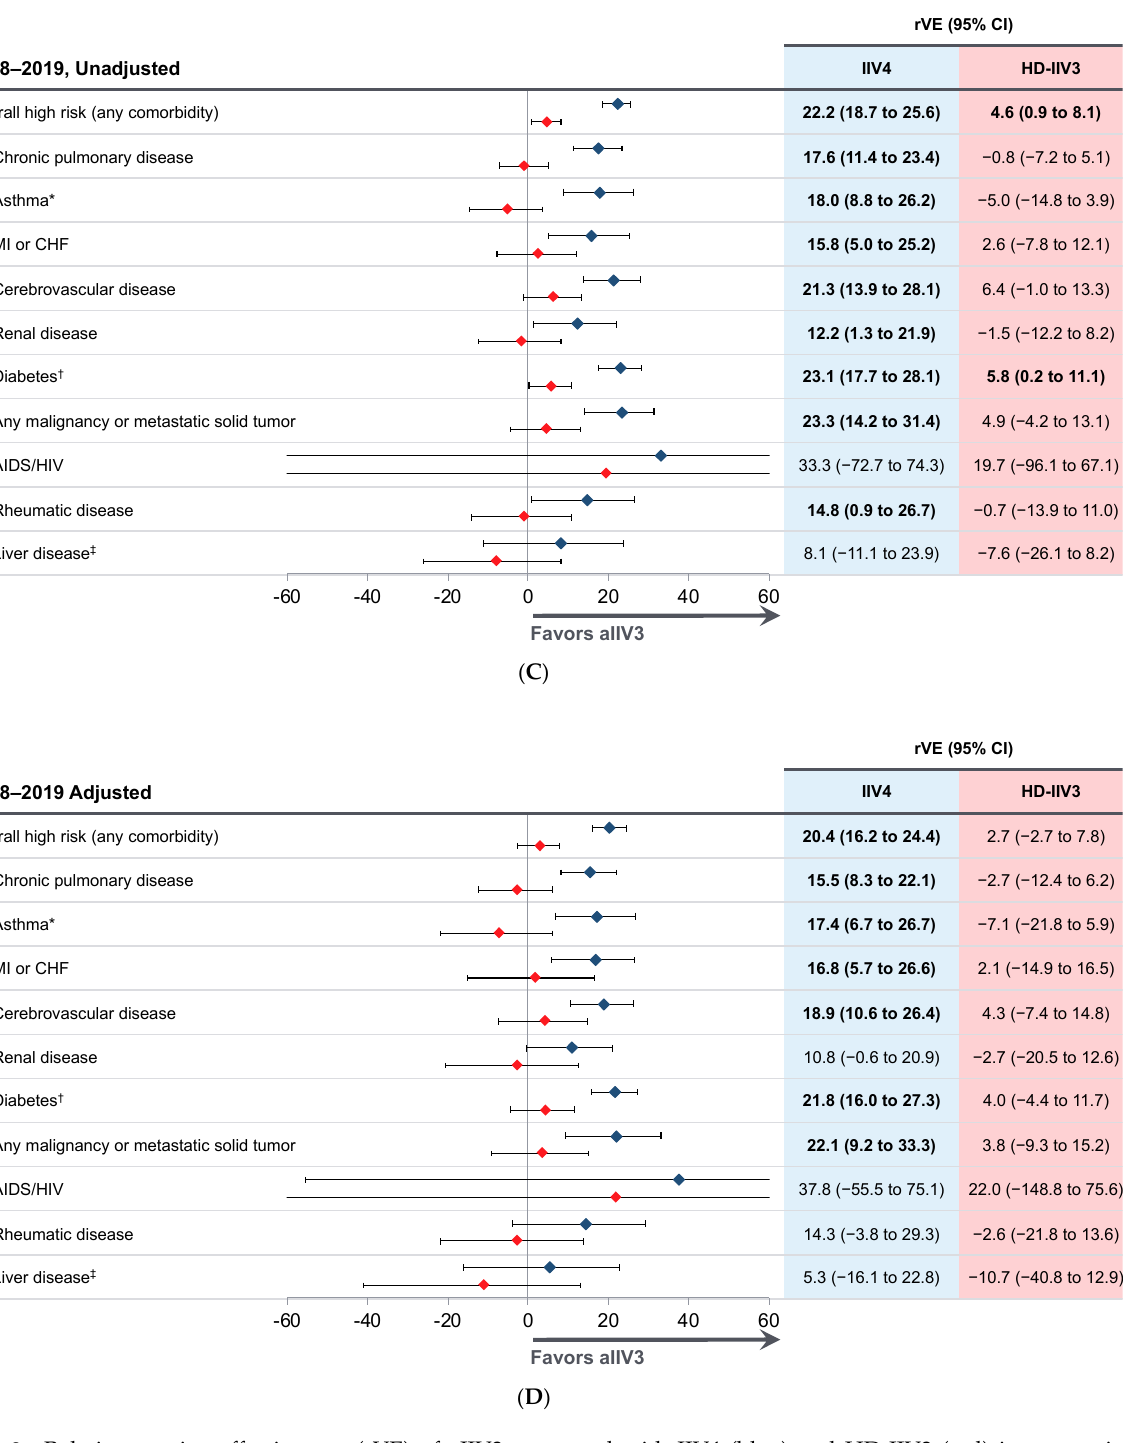
Figure 2. Relative vaccine effectiveness (rVE) of aIIV3 compared with IIV4 (blue) and HD-IIV3 (red) in preventing influenza-related medical encounters (defined by Armed Forces Health Surveillance Center (AFHSC) Code Set B) among adults ≥ 65 years in the 2017–2018 and 2018–2019 influenza seasons. ( A ) Unadjusted, 2017–2018 season. ( B ) Adjusted, 2017–2018 season. ( C ) Unadjusted, 2018–2019 season. ( D ) Adjusted, 2018–2019 season. Adjusted for age, sex, race, ethnicity, geographic region, week of influenza vaccination, and health status. Boldface indicates statistical significance. aIIV3, adjuvanted trivalent inactivated influenza virus; HD-IIV3, high-dose trivalent inactivated influenza virus; IIV4, quadrivalent inactivated influenza virus. * Subcategory of chronic pulmonary disease. † With or without chronic complications. ‡ Mild, moderate, or